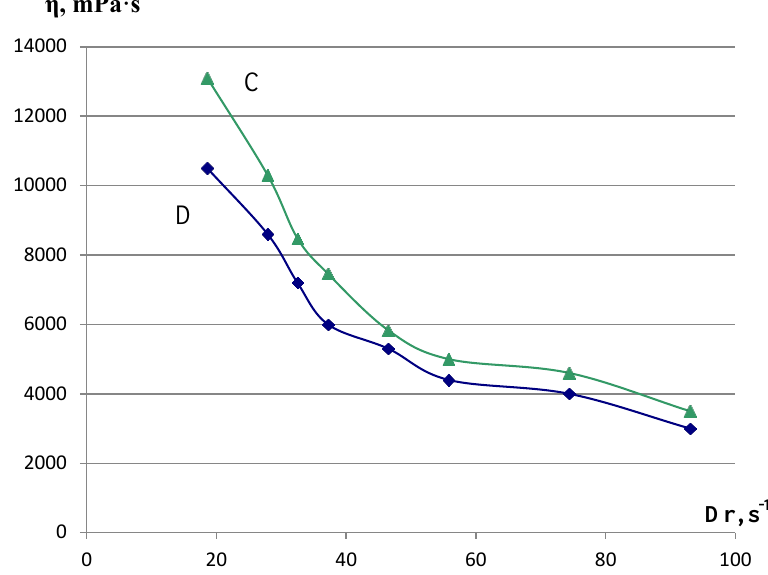
Fig. 2. Dependence of structural viscosity of gels with hydrocortisone on shear rate: sample C, sample D